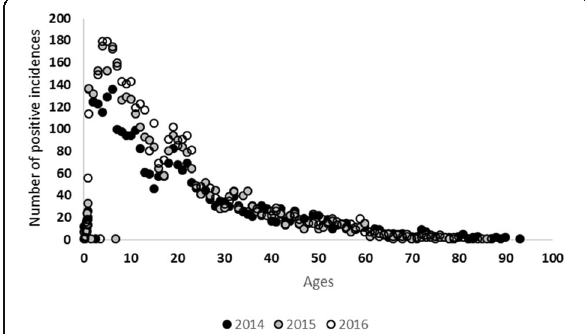
Fig. 3 Age distribution of patients with dengue incidence reported by Bandung hospitals 2014 –